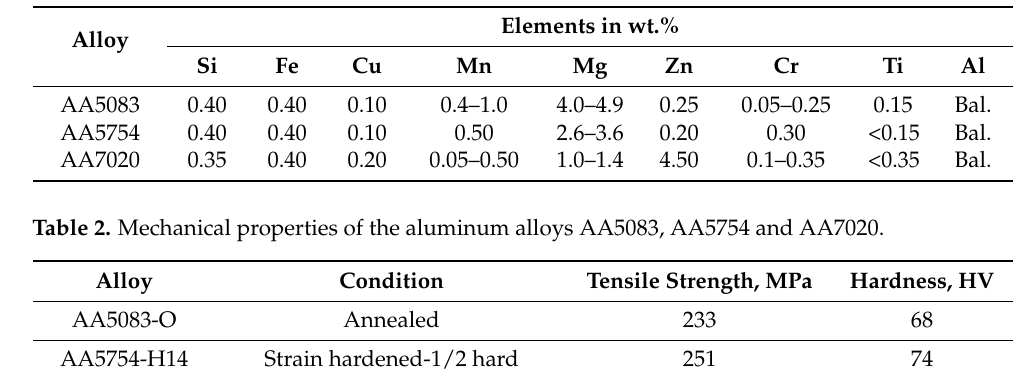
Table 1. Nominal chemical composition of aluminum alloys AA5083, AA5754 and AA7020. Alloy